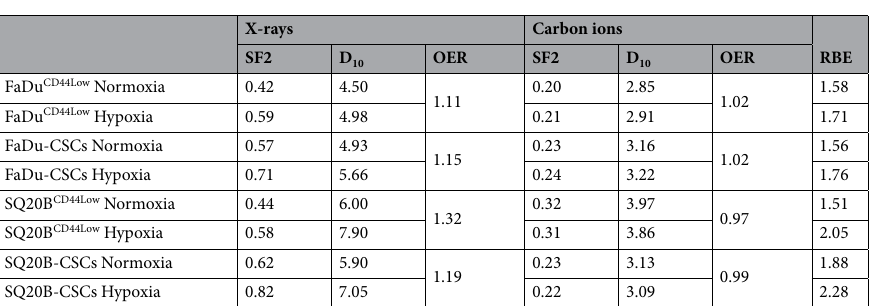
X-rays Carbon ions RBESF2 D